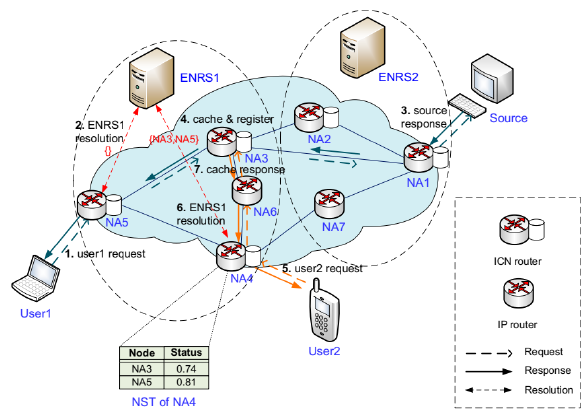
Figure 2. Overview of ERS